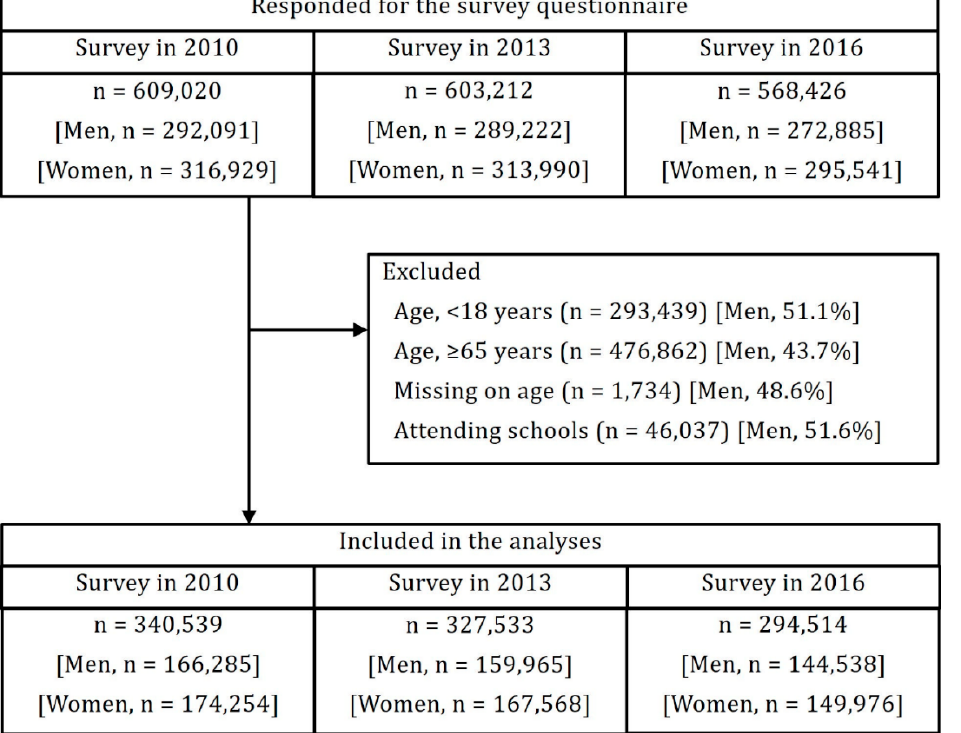
Figure 1. Flow chart diagram of participants for each year of the survey.